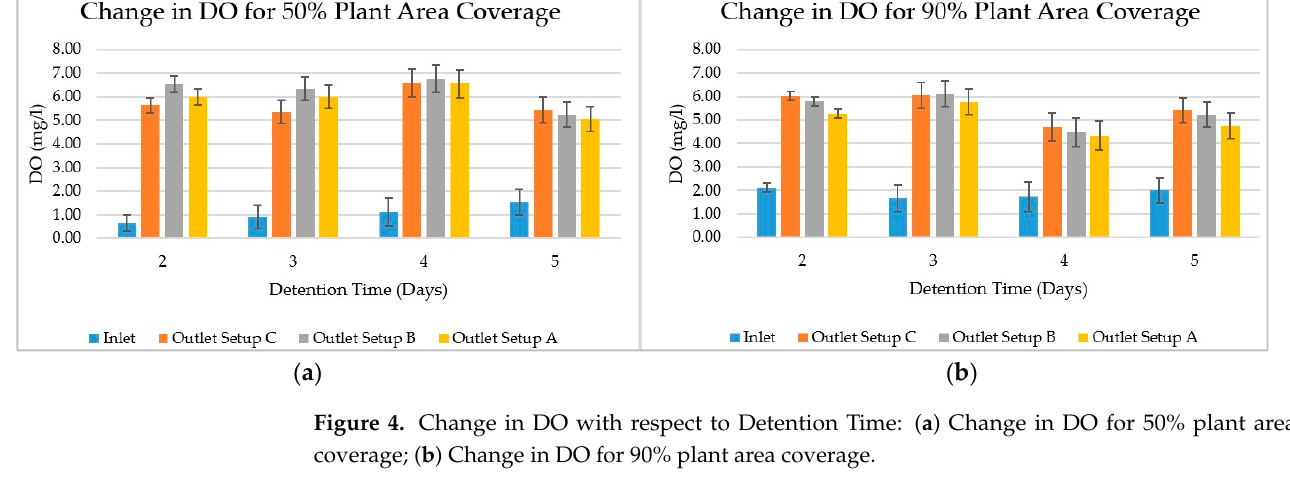
Figure 4. Change in DO with respect to Detention Time: ( a ) Change in DO for 50% plant area coverage; ( b ) Change in DO for 90% plant area coverage.